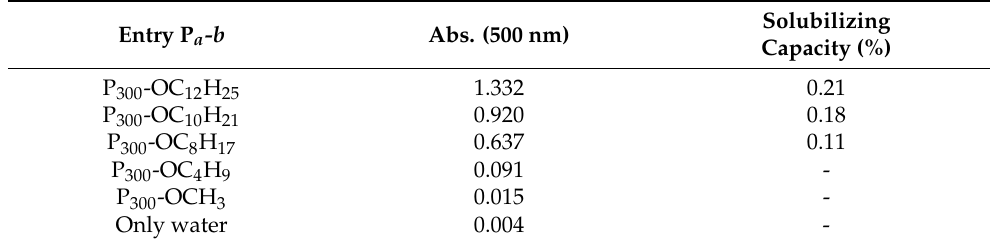
Table 7. Dependence of solubilizing ability of poly(alkyloxyethylene phosphate) based on PEG 300 from alkyl chain length. The value of solubilizing capacity was calculated for the polymers for which the size of the micelle could be